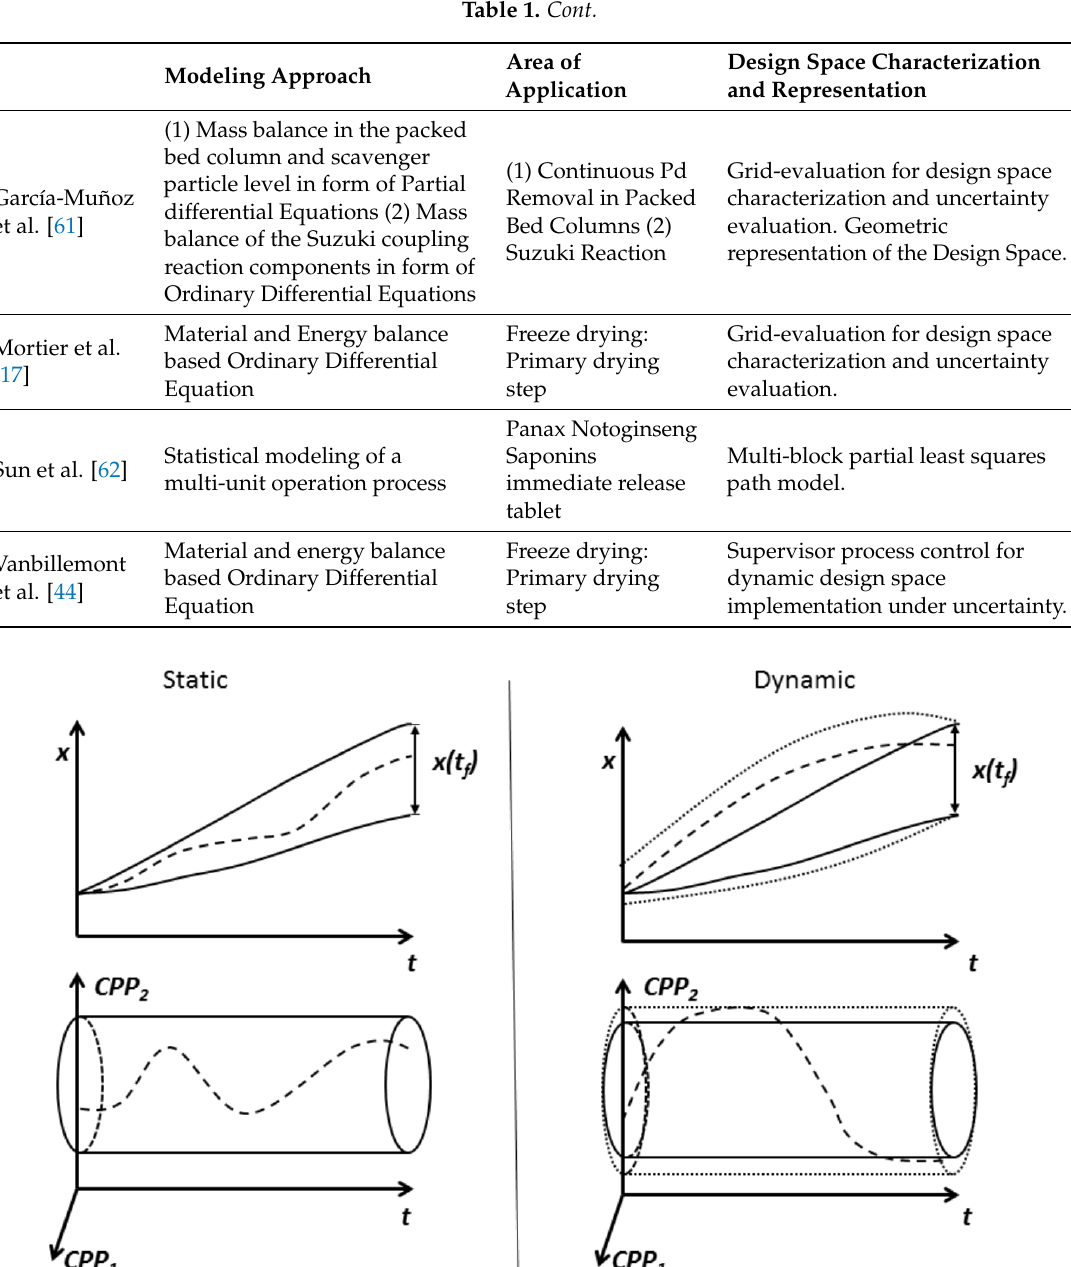
Figure 2. Illustration of the static and dynamic design space. Continuous lines: Static design space boundaries and the respective boundaries of the state (at the end of the process the boundaries of the state are assumed to be identical to the Critical Quality Attribute (CQA) acceptance limits). Dashed lines: Trajectory of the parameter and respective state trajectory for one process; i.e., p and x ( t ) . Dotted Line: Dynamic design space boundaries; moving temporally outside means that the final CQA acceptance criterion can no longer be